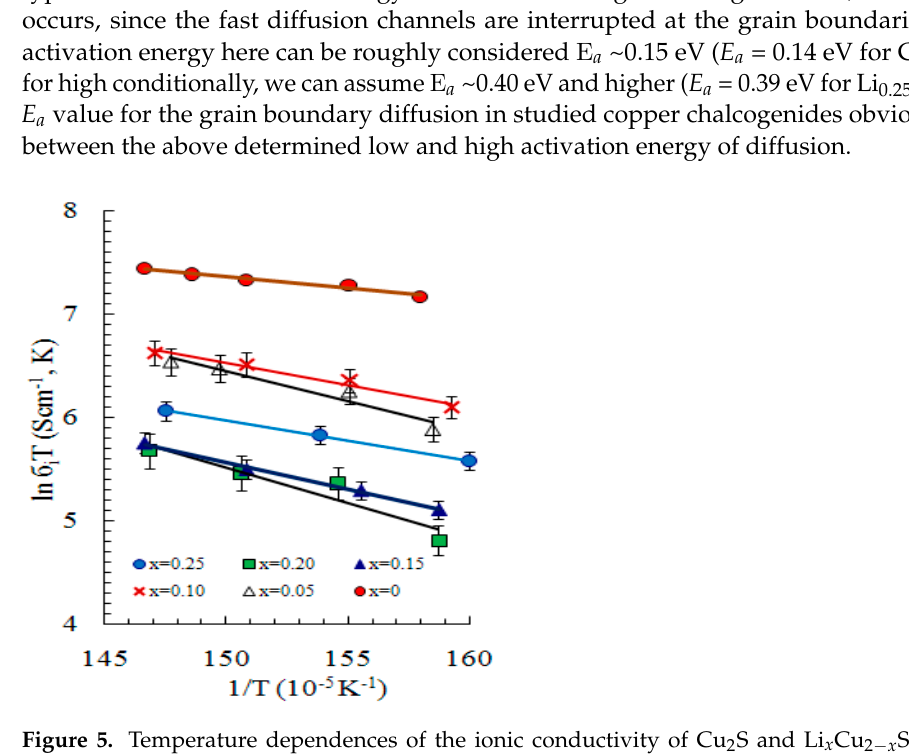
Figure 5. Temperature dependences of the ionic conductivity of Cu 2 S and Li x Cu 2 − x S samples. Reprinted from reference [24]. Copyright 2003 John Wiley and Sons.